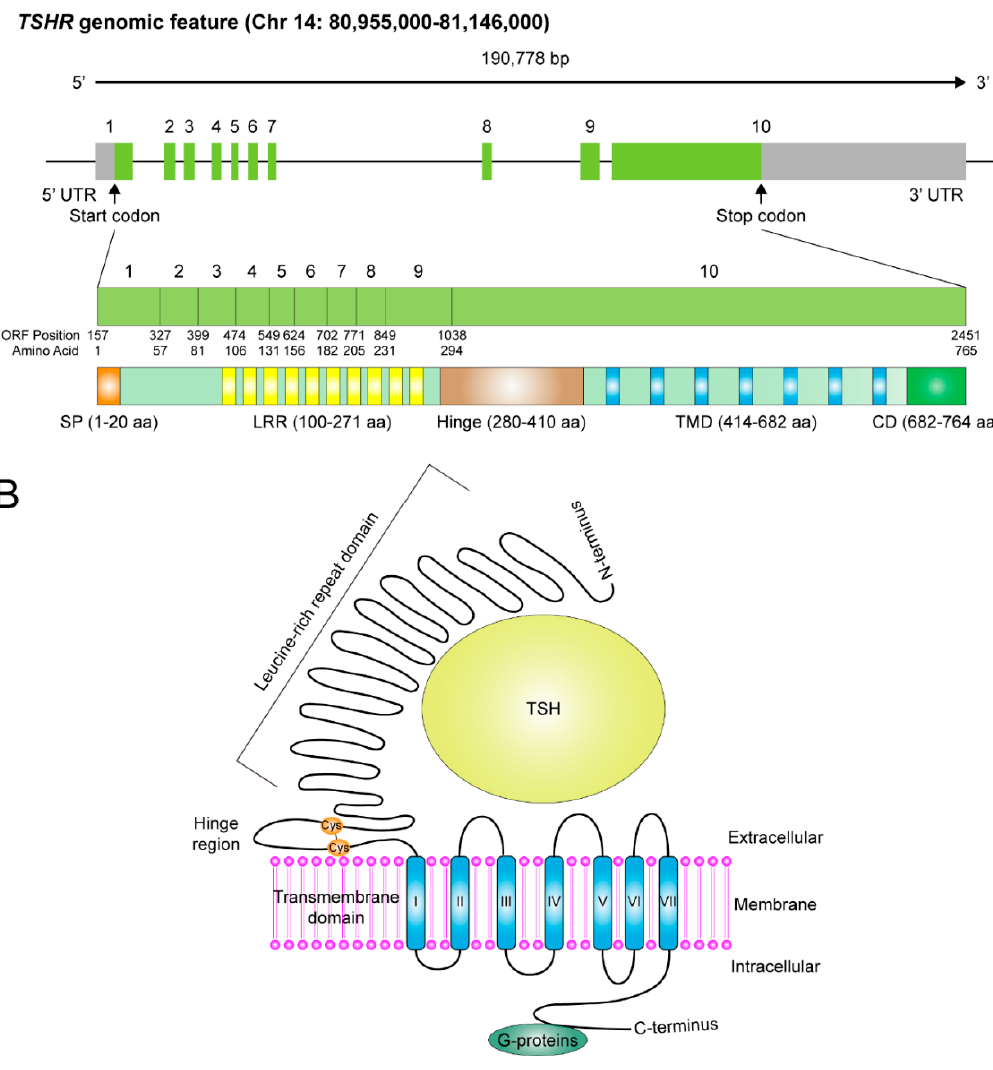
Figure 1. The genomic features and protein structure of thyroid stimulating hormone receptor (TSHR). ( A ) Schematic representation of the genomic structure of TSHR gene. The corresponding numbers of nucleotides and amino acids for the protein domains within the coding region are shown in this diagram. SP, signal peptide. LRR, leucine-rich repeat domain. TMD, transmembrane domain. CD, intracytoplasmic domain. ( B ) The schematic diagram represents the folded protein structure of TSHR, in which a large extracellular domain, including the hinge and leucine-rich repeat domain, the transmembrane domain and the intracytoplasmic domain are depicted. Cys, cysteine, where disulfide bonds formed.